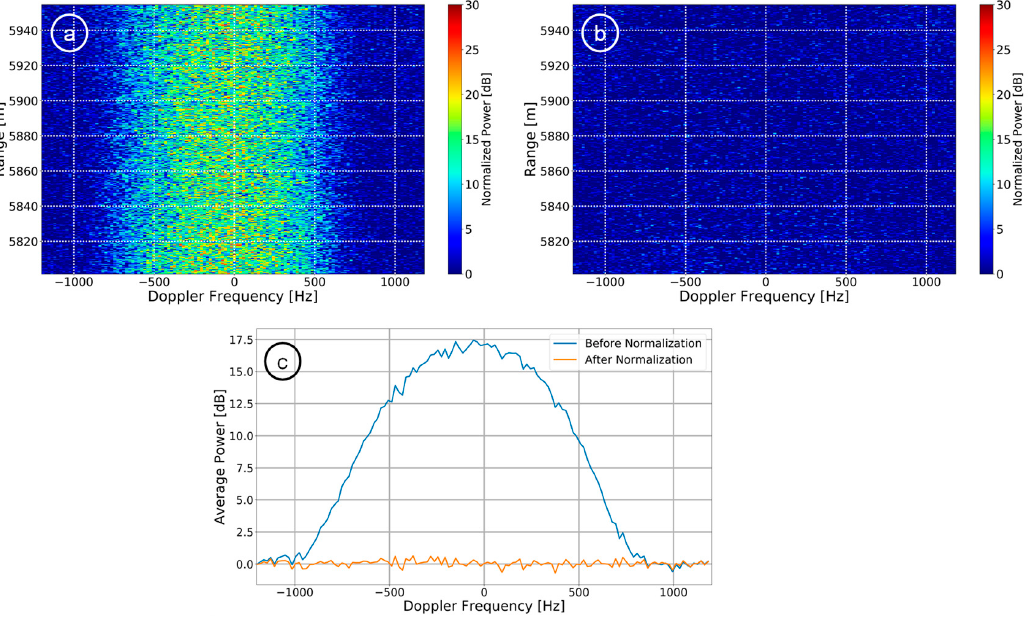
Figure 15. Range-Doppler image of a target free image patch ( a ) before and ( b ) after clutter Figure15. Range-Dopplerimageofatargetfreeimagepatch( a )beforeand( b )afterclutternormalization. The normalized average power profiles of ( a , b ) are shown in ( c normalization. The normalized average power profiles of ( a ) and ( b ) are shown in ( c ).